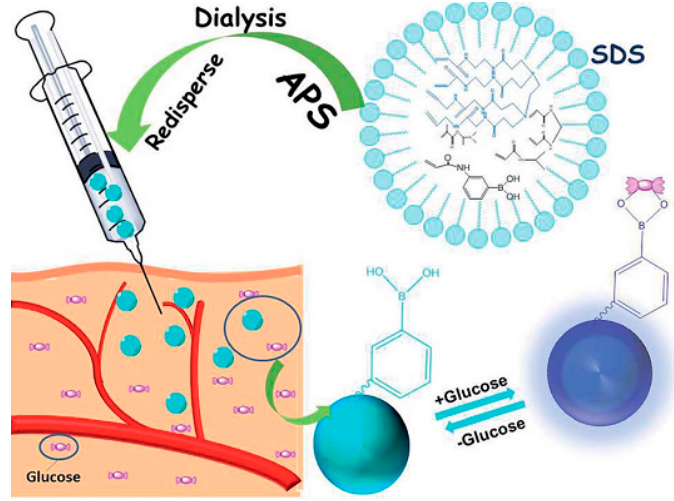
Figure 1. The schematic illustration of G1.0 PAMAM-functionalized microgels that can recognize glucose and emit blue fluorescence after injection. Reprinted with permission from [36].